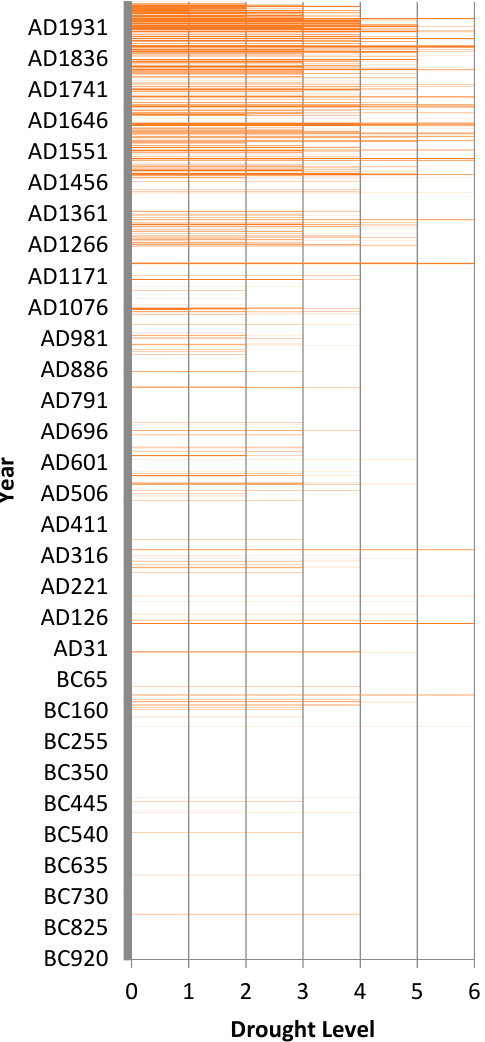
Figure 3. Historical drought grades in the Fenhe River basin from BC 900 to AD 2012.